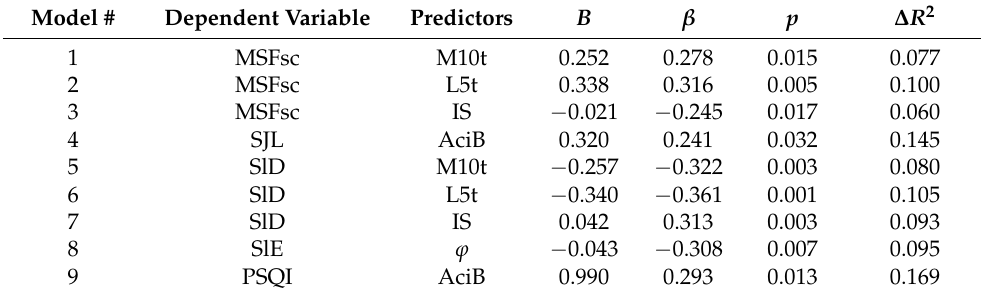
Table 7. Associations among sleep–wake rhythm and 24 h rest–activity rhythm characteristics. Model